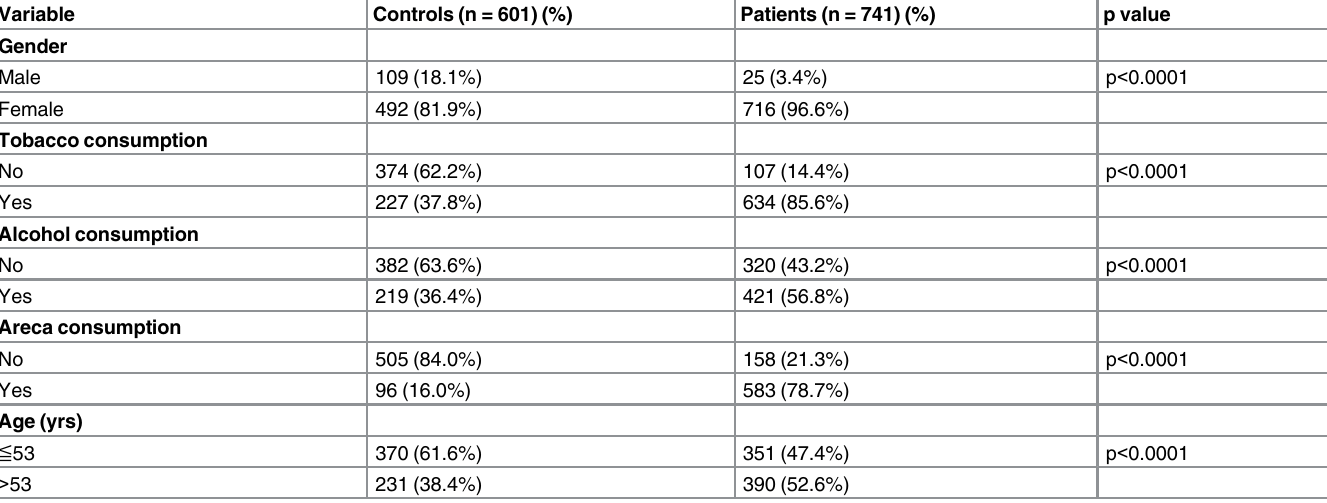
Table 1. The distributions of demographical characteristics in healthy controls and patients with oral